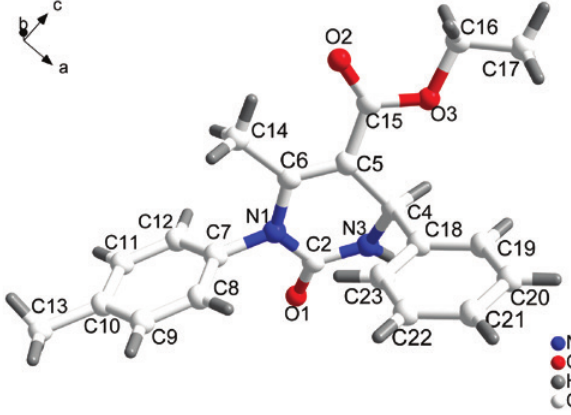
Figure 1: The molecular structure of the compound t .